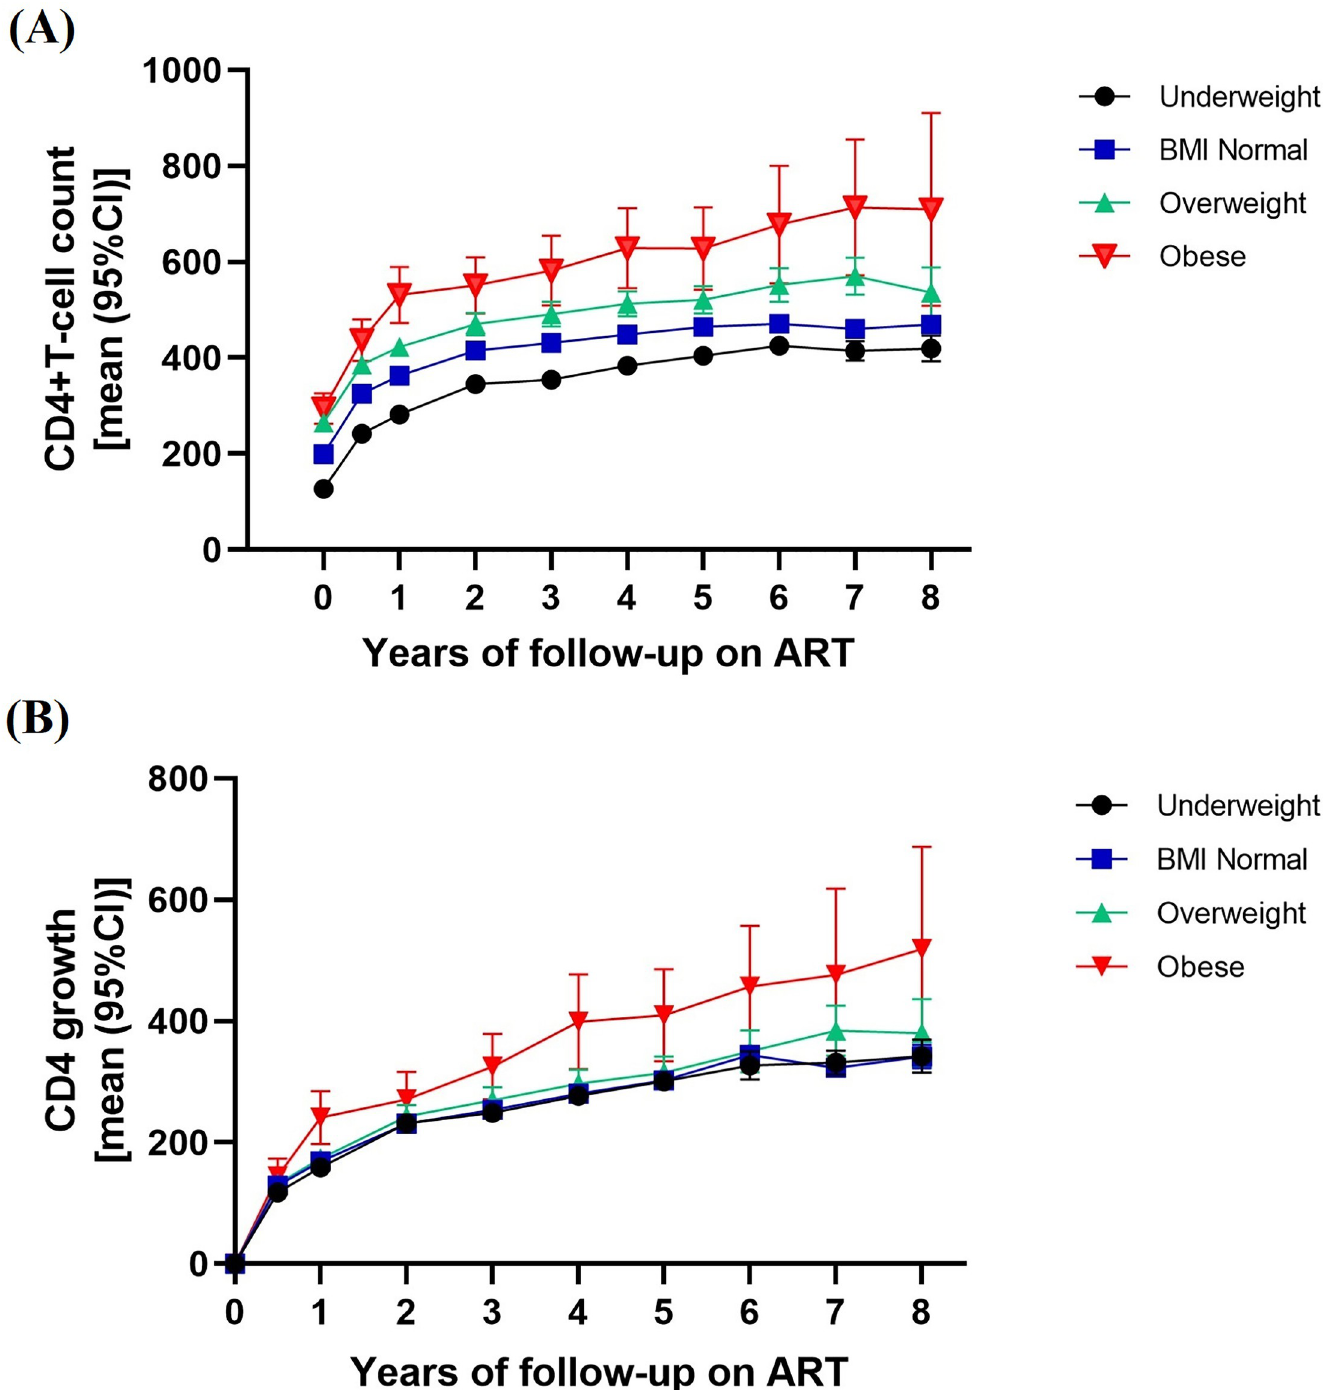
Fig 2. Immune recovery and growth in different BMI categories during 8-year ART treatment. (A) shows immune recovery by BMI categories from the start of ART to the 8th year of follow-up; (B) shows Mean increase in CD4 cell count from the start of ART to the 8th year of follow-up.